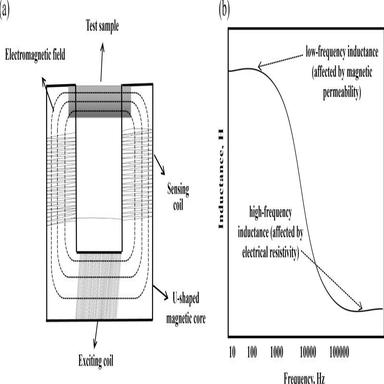
(a) Schematic of a U-shaped electromagnetic sensor, (b) the signal of inductance vs frequency output by the sensor.